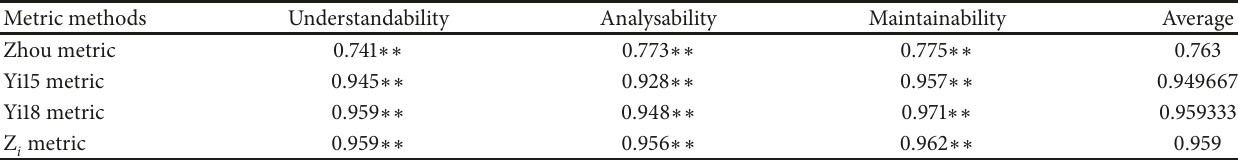
Table 4: The correlation analysis of the complexity measurement